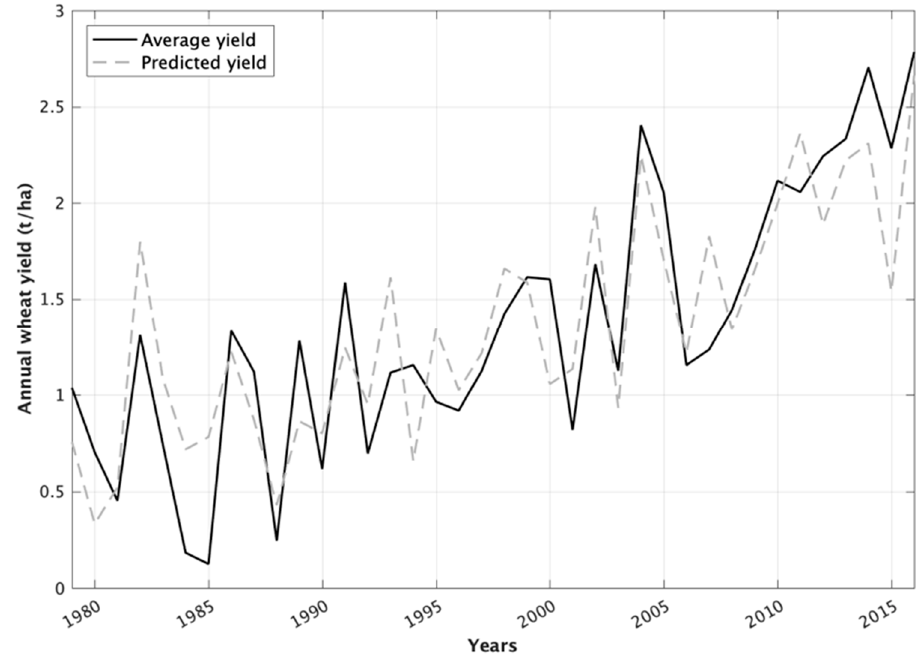
Figure 12. Average vs. predicted wheat yield for rural municipality # 17 (1979–2016) (Dry Brown soil zone).